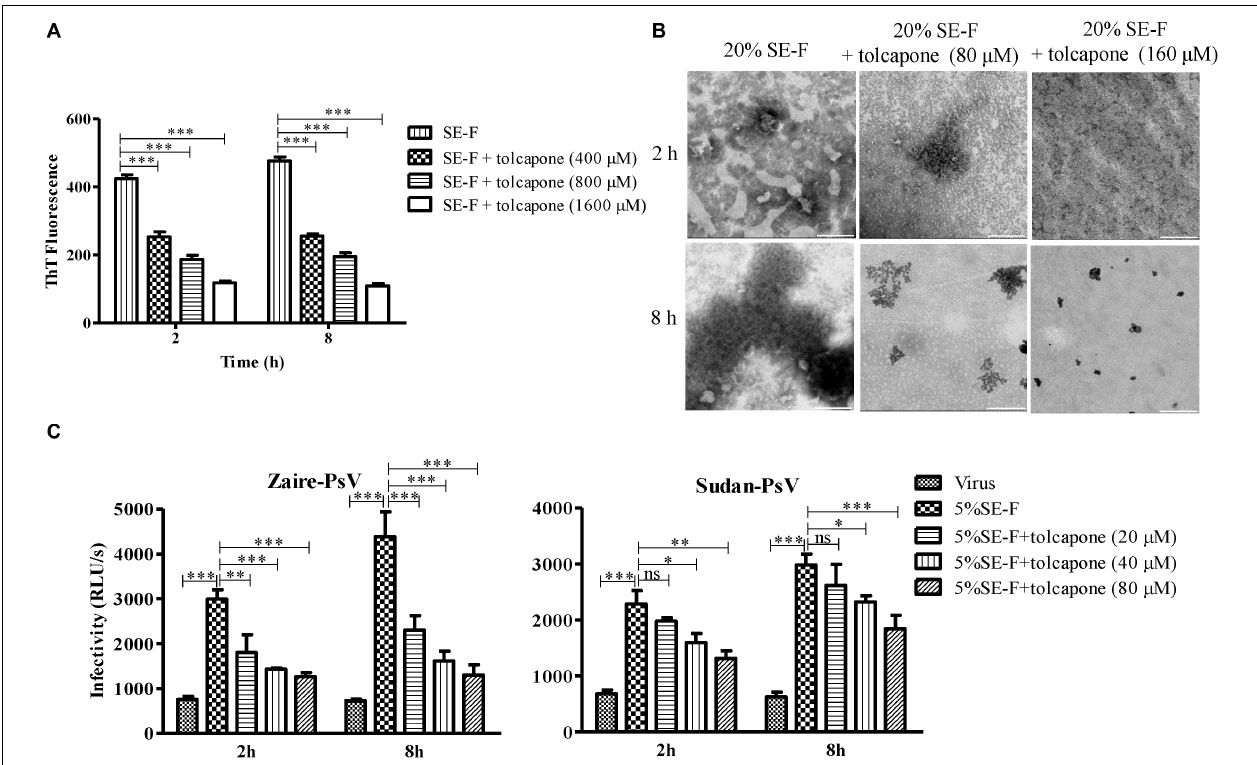
FIGURE 3 | Tolcapone antagonizes the assembly of endogenous seminal amyloid fibrils. (A) Seminal amyloid fibril formation was antagonized by tolcapone in a dose-dependent manner. Fresh seminal fluid (SE-F) samples with tolcapone (0, 400, 800, and 1,600 µ M) were agitated at 1,400 rpm at 37 ◦ C for 8 h. Fibril integrity at 2 and 8 h was detected by thioflavin T (ThT) assay. The data represent the mean ± SD of three independent experiments. ∗ p < 0.05; ∗∗ p < 0.01; ∗∗∗ p < 0.001; two-way ANOVA. (B) Samples of seminal fibrils (1:5 dilutions) in the presence or absence of tolcapone (80 and 160 µ M) after agitation for 2 and 8 h were visualized by transmission electron microscopy (TEM). Scale bars indicate 200 nm. (C) SE-F in the presence of tolcapone at the graded concentrations was agitated to allow fibril formation. The fibrils in the pellet were tested on their abilities to infect Zaire-PsV (left panel) and Sudan-PsV (right panel) in HeLa after 72 h. SE-F was finally diluted 20-fold. Shown are means ± SD of three independent experiments. ∗ p < 0.05; ∗∗ p < 0.01; ∗∗∗ p < 0.001; two-way